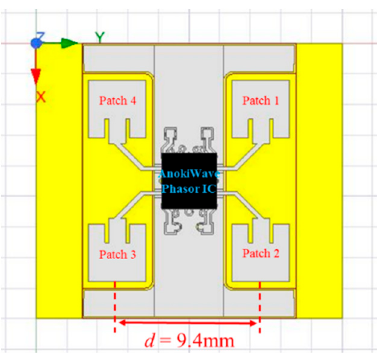
Figure 5. The structure of proposed array antenna with phasor IC.